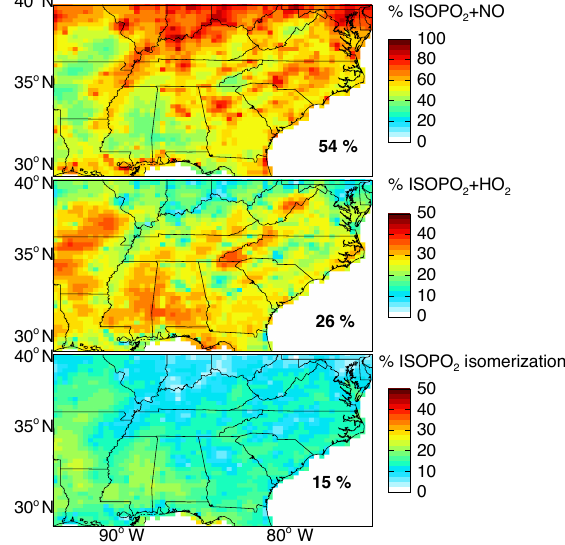
Figure 7. Branching ratios for the fate of the isoprene peroxy radical (ISOPO 2 ) as simulated by GEOS-Chem over the Southeast US for August–September 2013. Values are percentages of ISOPO 2 that react with NO, HO 2 , or isomerize from the total mass of isoprene reacting over the domain. Note the difference in scale between the top panel and the lower two panels. Regional mean percentages for the Southeast US are shown inset. They add up to less than 100% because of the small ISOPO 2 sink from reaction with other organic peroxy radicals (RO 2 ) .